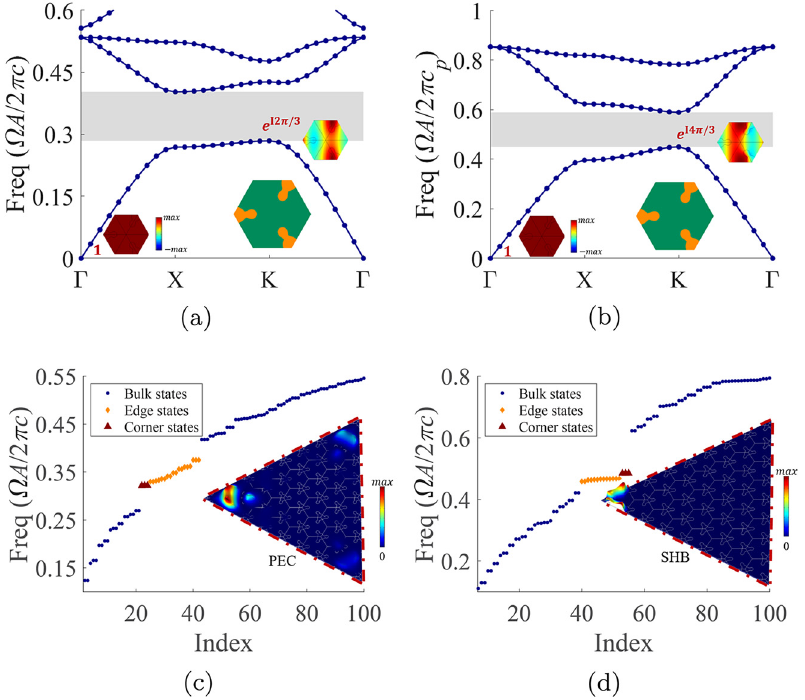
-symmetric photonic HOTI. (a) and (b) The unit cell and the photonic and phononic band structures with SIs Figure 4: The optimized C 3 illustrated by the inserted eigenstates; (c) and (d) the photonic and phononic spectrum and highly localized corner states with truncation. The inserted eigenstates illustrate their energy field of corner states. All free boundaries (the red dash-dot lines) for TM/acoustic wave are set as PEC/Sound hHard bBoundary (SHB) by default in this